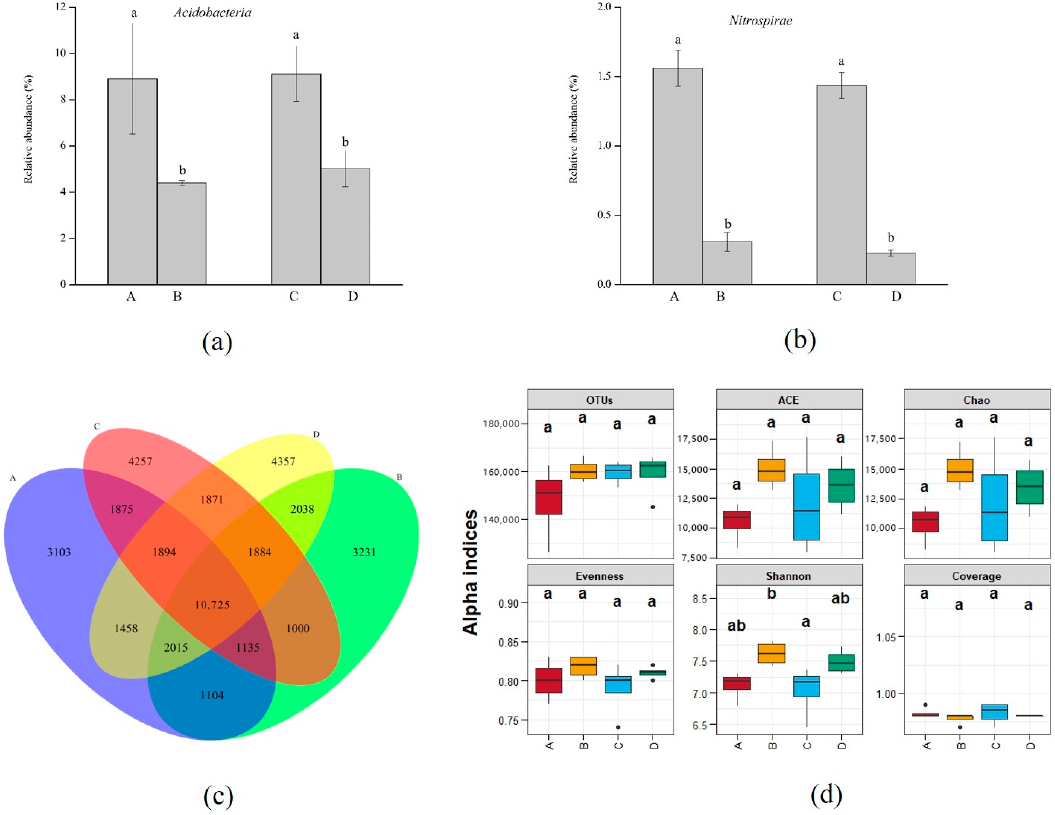
Figure 7. Relative abundance of Acidobacteria ( a ) and Nitrospirae ( b ) at the phylum level for four groups. The Venn diagram ( c ) and Alpha diversity analysis ( d ) for four groups. Note: A and B represented the high-polluted group (Location 1–4) and the low-polluted level group (Location 5–8) soil collected in July 2018; C and D represented the high-polluted level group (Location 1–4) and low-polluted level group (Location 5–8) soil collected in January 2019; Error bars indicate standard error ( n = 4). Small letters indicate significant differences among the four groups by one-way ANOVA tests ( p < 0.05) .